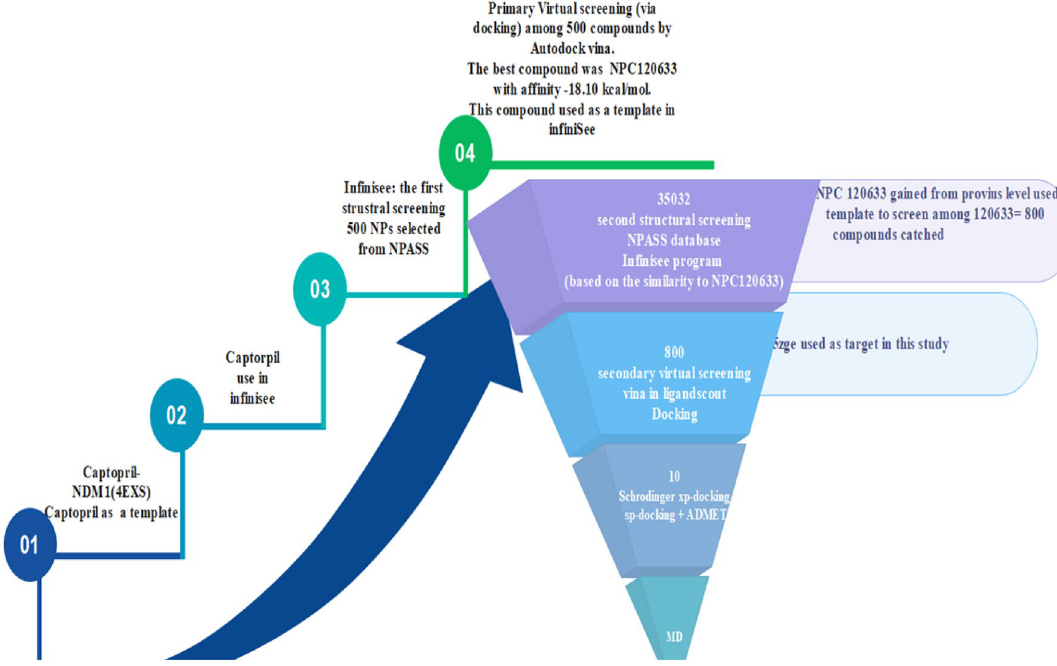
Figure 1. The procedure of this